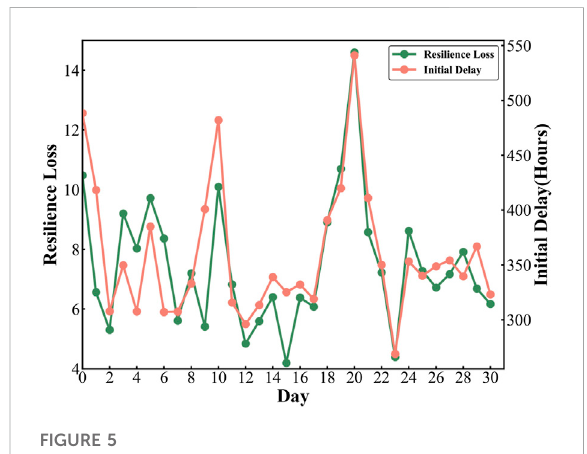
FIGURE 5 Relationship between the resilience loss and initial delay for different days.